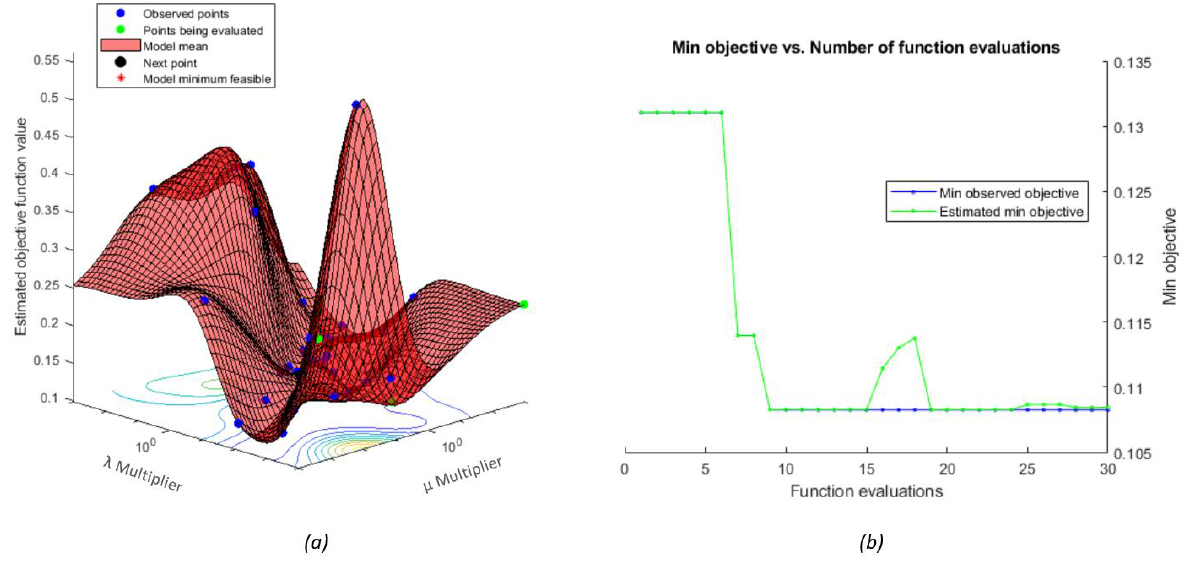
Figure 6. Estimated minimum objective function value across ( a ) the Lagrange multipliers and ( b ) the required function evaluations.